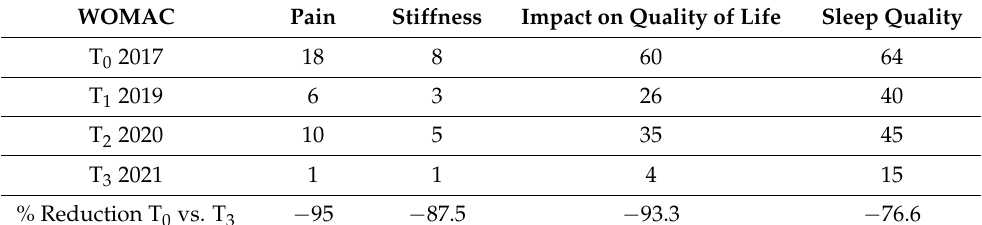
Table 1. Western Ontario and McMaster Universities Arthritis Index and Sleep Quality questionnaires. WOMAC Pain Stiffness Impact on Quality of Life Sleep Quality